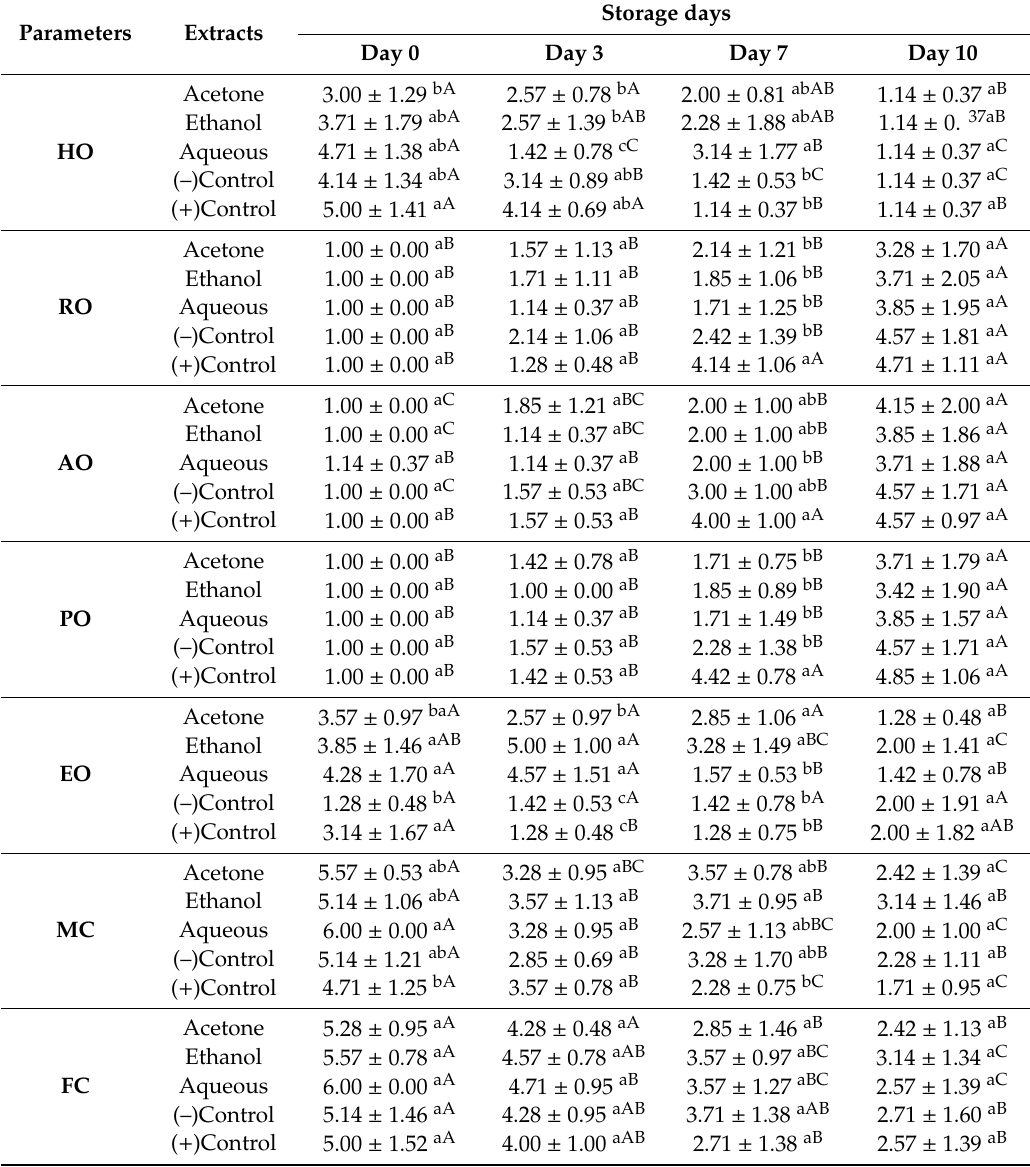
Table 5. Scores for in beef burgers added Oudneya africana leaves extracts (0.03%) and commercial mixed (2%) stored at 4 ◦ C during 10